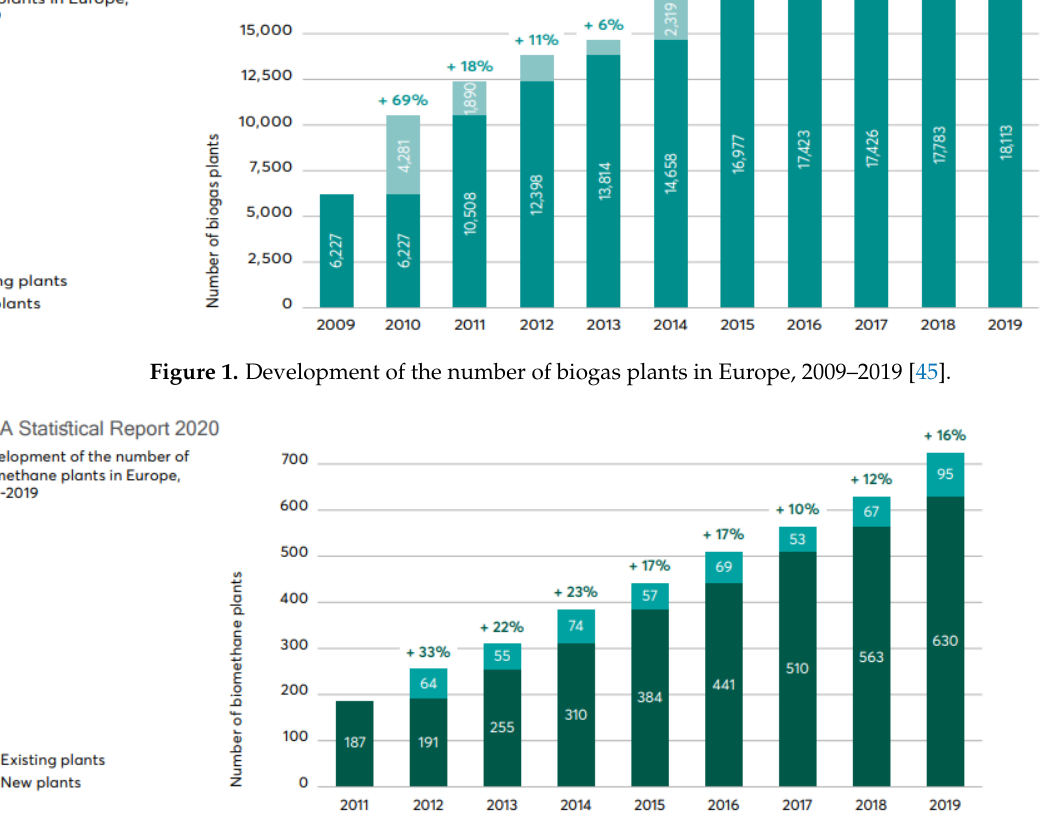
Figure 2. Development of the number of biomethane plants in Europe, 2011–2019 [45].